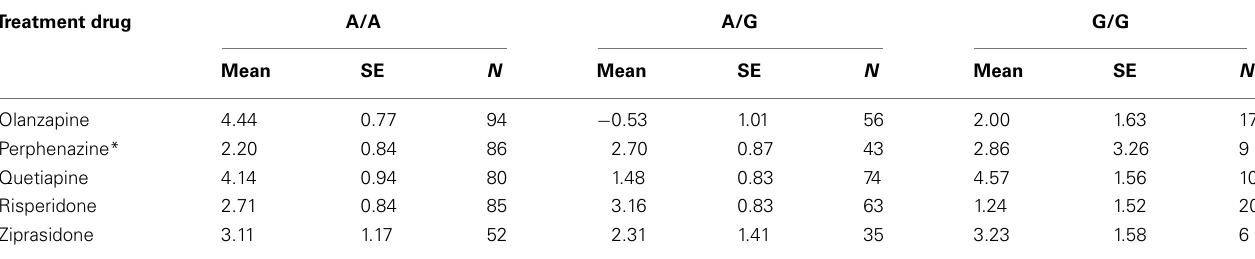
*Except Perphenazine, which is first generation antipsychotic drug, all treatment drugs in table are second generation antipsychotic